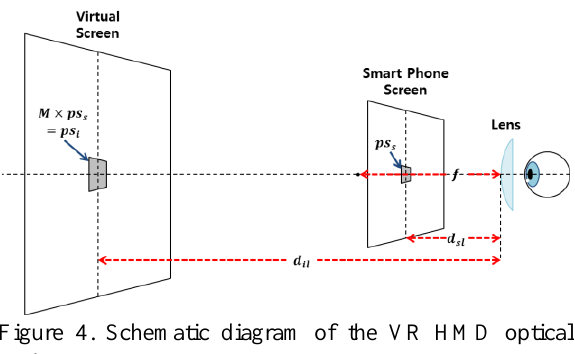
Figure 4. Schematic diagram of the VR HMD